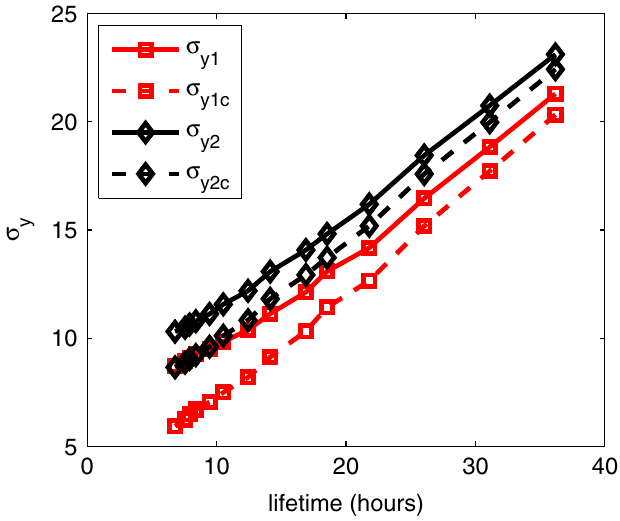
FIG. 15. (Color) Vertical beam size vs lifetime measured at the two